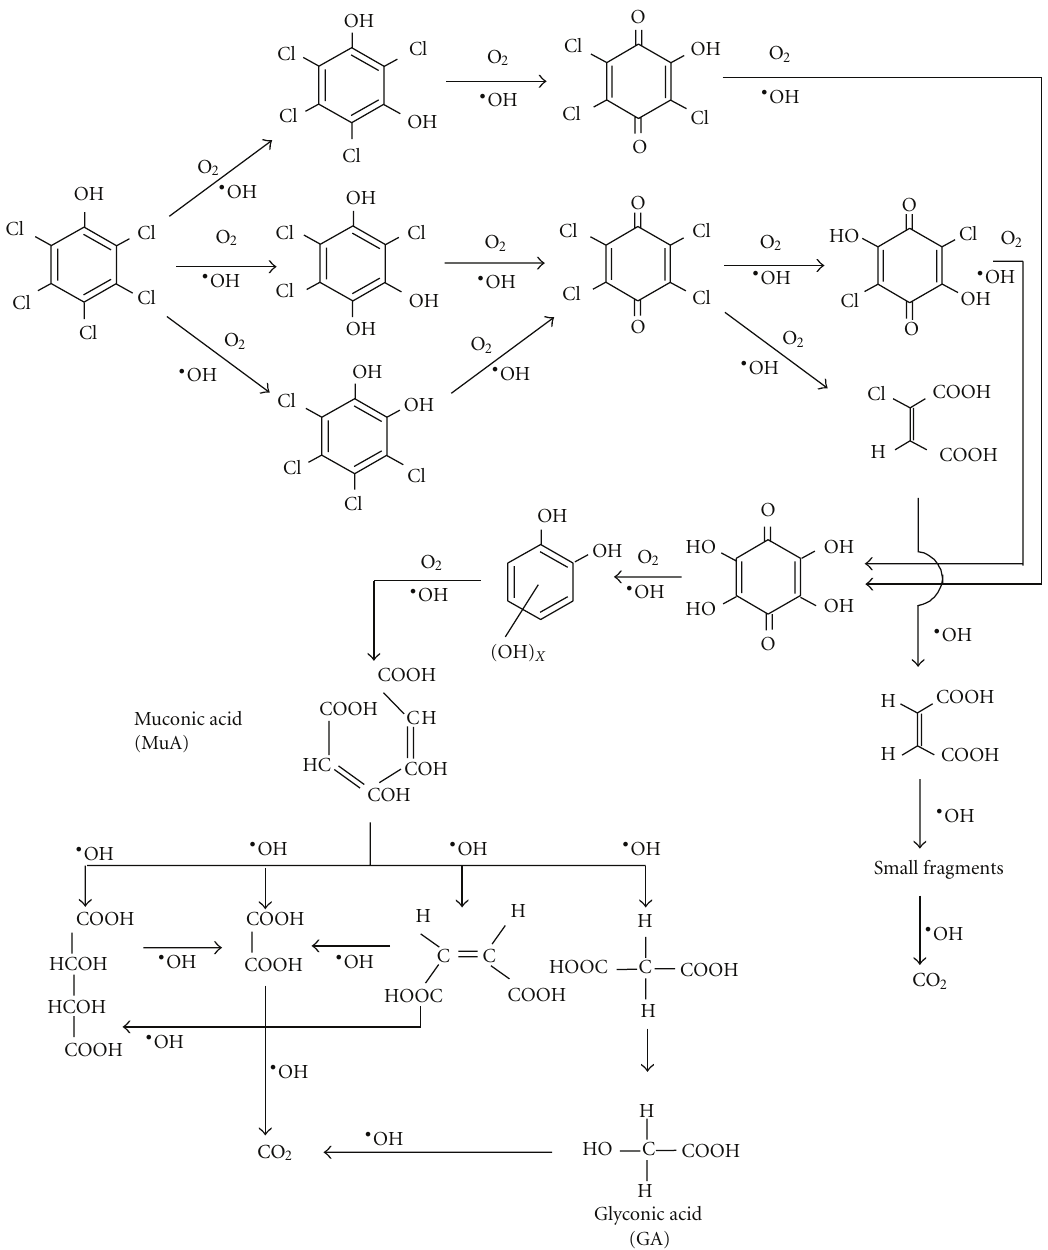
Figure 10: Photocatalytic degradation scheme for PCP